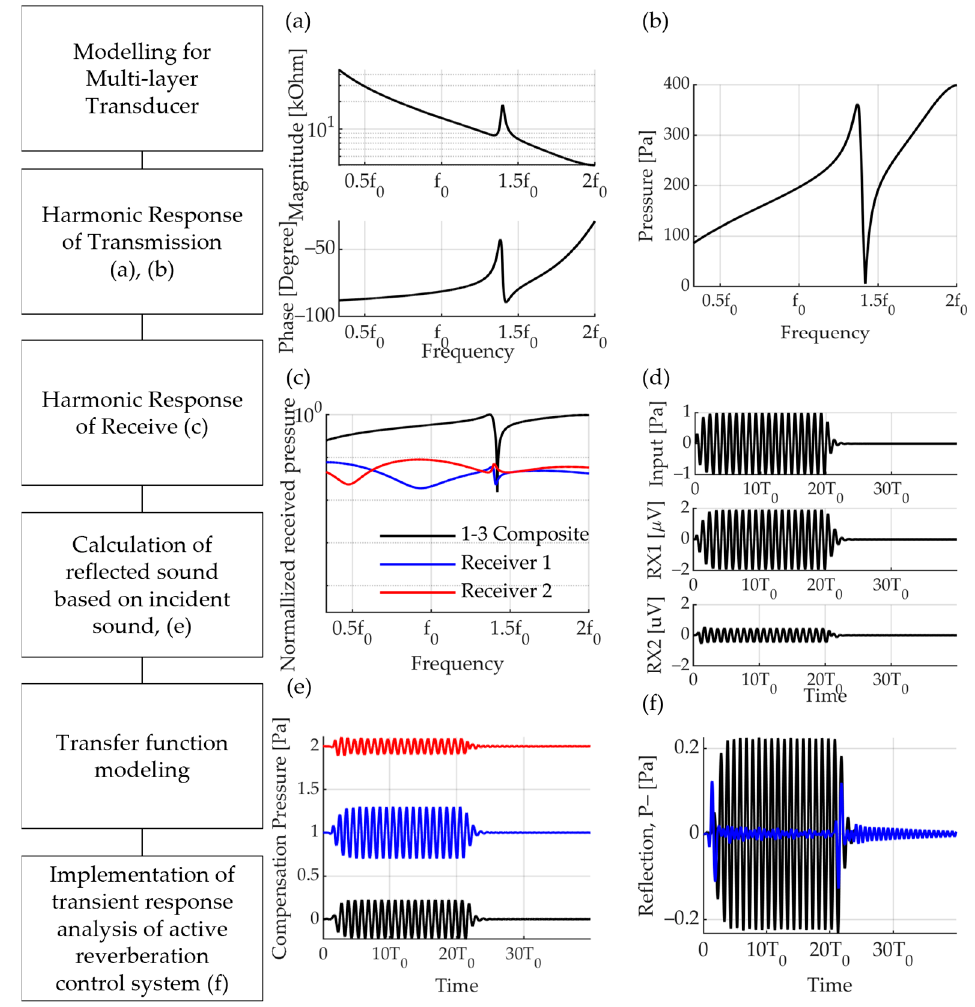
Figure 6. Algorithm of analytical model for active reflection control. ( a ) Electrical impedance; ( b ) harmonic response of transmitter; ( c ) harmonic response of receiver; ( d ) time domain analysis of reception sensitivity according to unit pressure input; ( e ) compensation pressure for reflection control; ( f ) reflection pressure with only passive attenuation (black) and with active reflection control applied (blue).